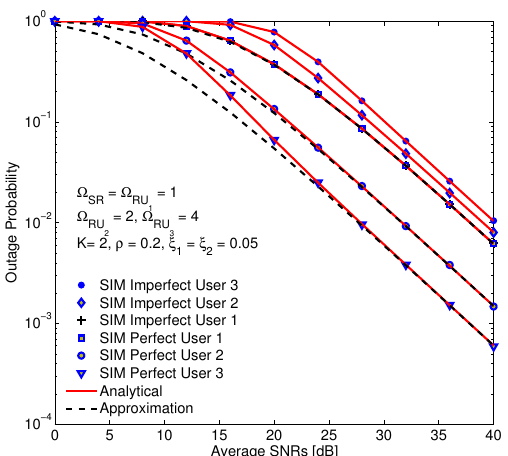
Figure 8. The OP of users in term of imperfect and perfect SIC with residual coefficients of SIC are ξ 1 = ξ 2 = 0.05, and α = 0.3, η = 0.85, a 1 = 0.6, a 2 = 0.3, a 3 = 0.1